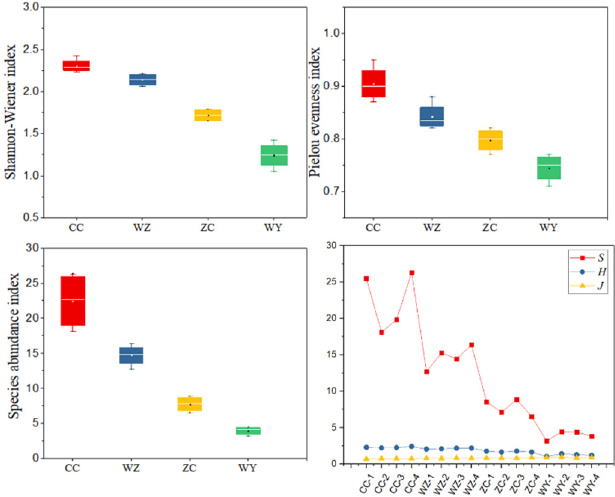
Figure 8. Plant community species diversity index.